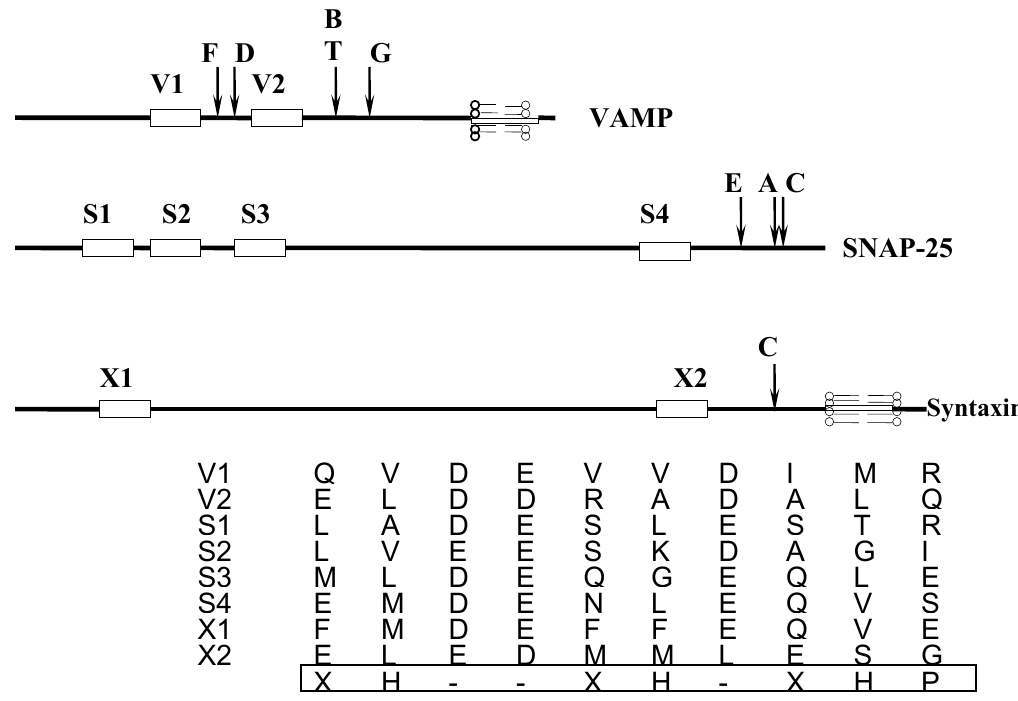
Figure 6. Positions of the SNARE motif in three substrates responsible for the target specificity of clostridial neurotoxins [200]. The motif consists of nine residues that are common to all three substrates: hydrophobic residue (H), Asp or Glu residue (-), polar residue (P), and any residue (X).